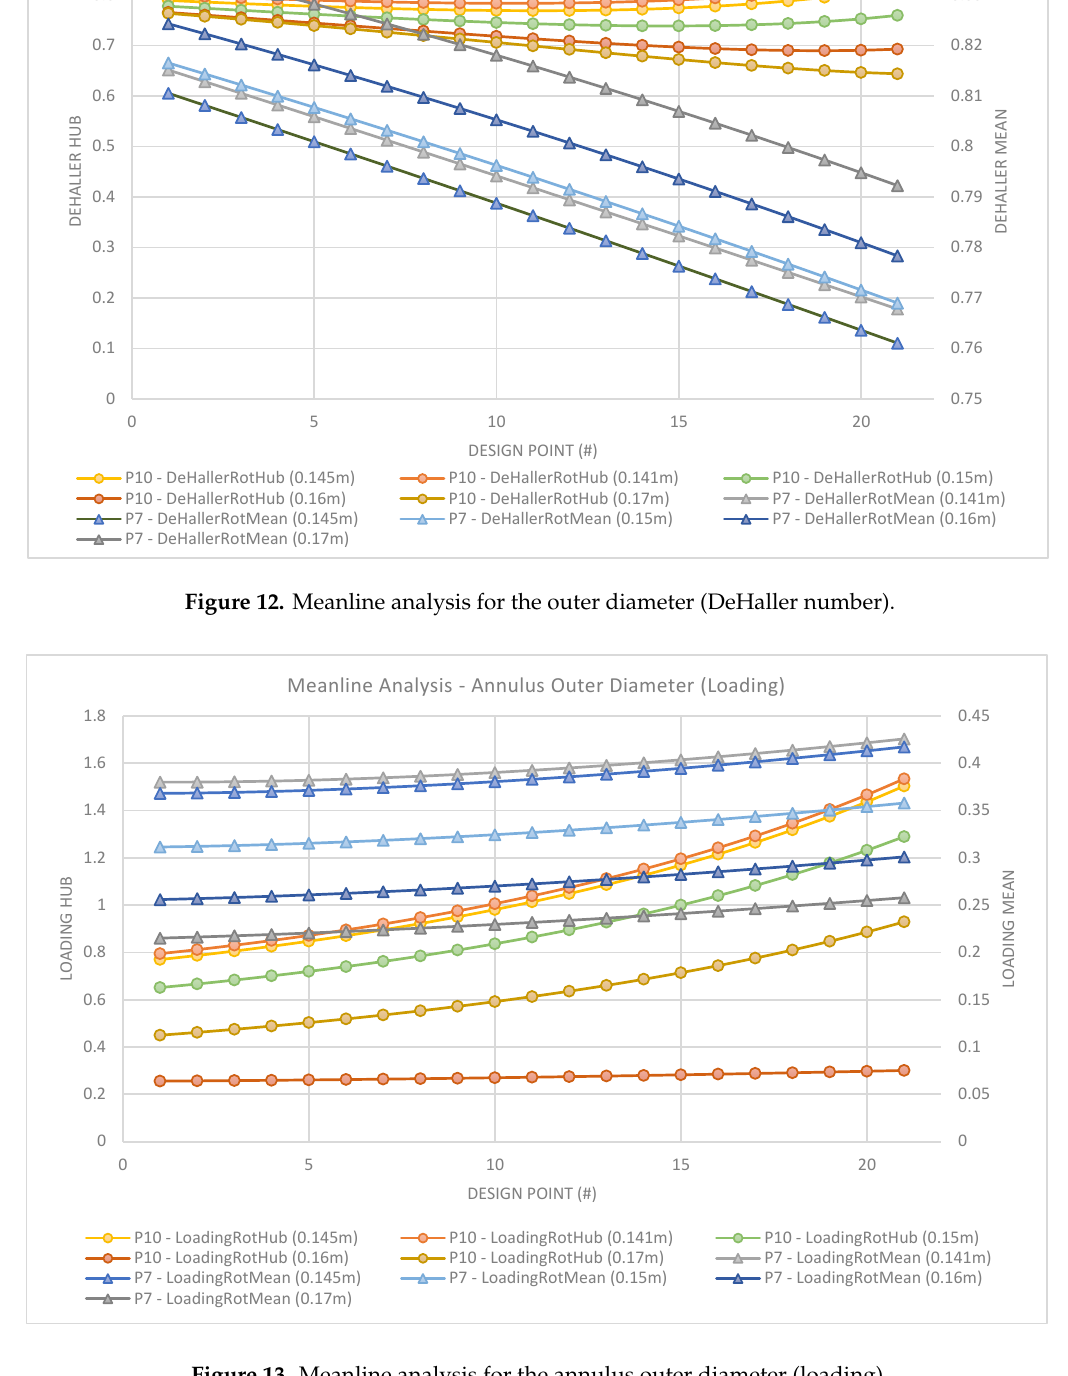
Figure 13. Meanline analysis for the annulus outer diameter (loading).